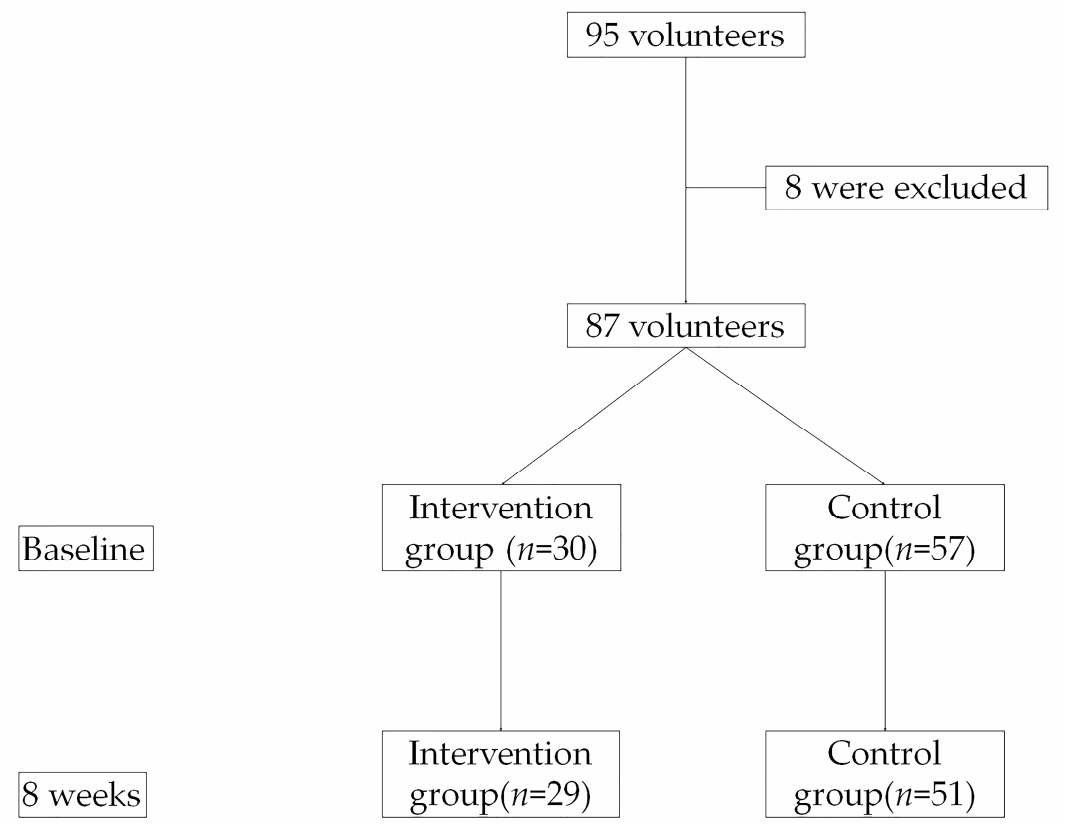
Figure 1. Flow Chart of Participants through the